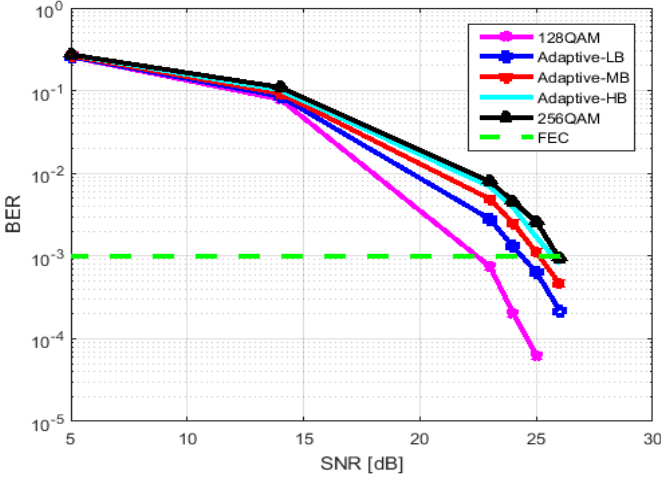
Figure 8. Three significant adaptive areas, low boost (LB), medium boost (MB), and high boost (HB) between two sequential fixed modulation schemes (128 and 256 QAM).